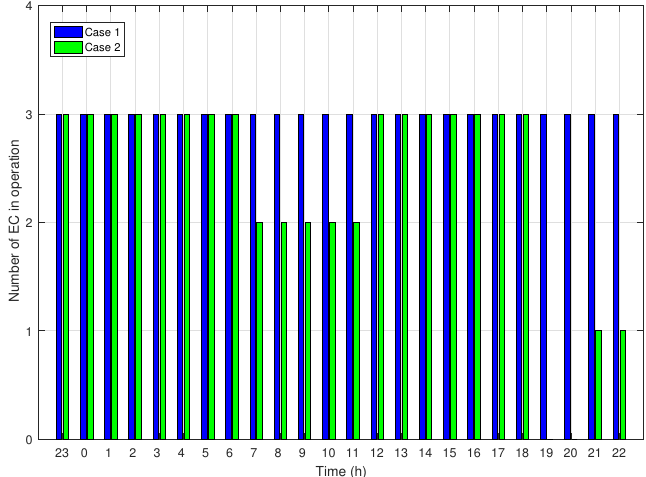
Figure 10. The on-state number of all ECs in different cases